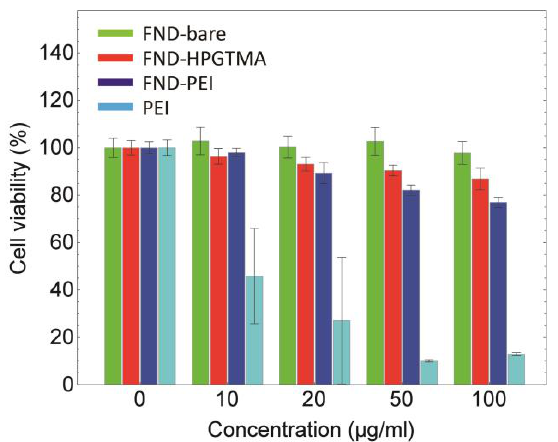
Figure 2. Cell viability testing of HeLa cells treated with FND-bare, FND-HPGTMA, and FND-PEI, and PEI for 24 h using CCK-8. Values are means ± standard deviations of three measurements. PEI: Polyethylenimine.